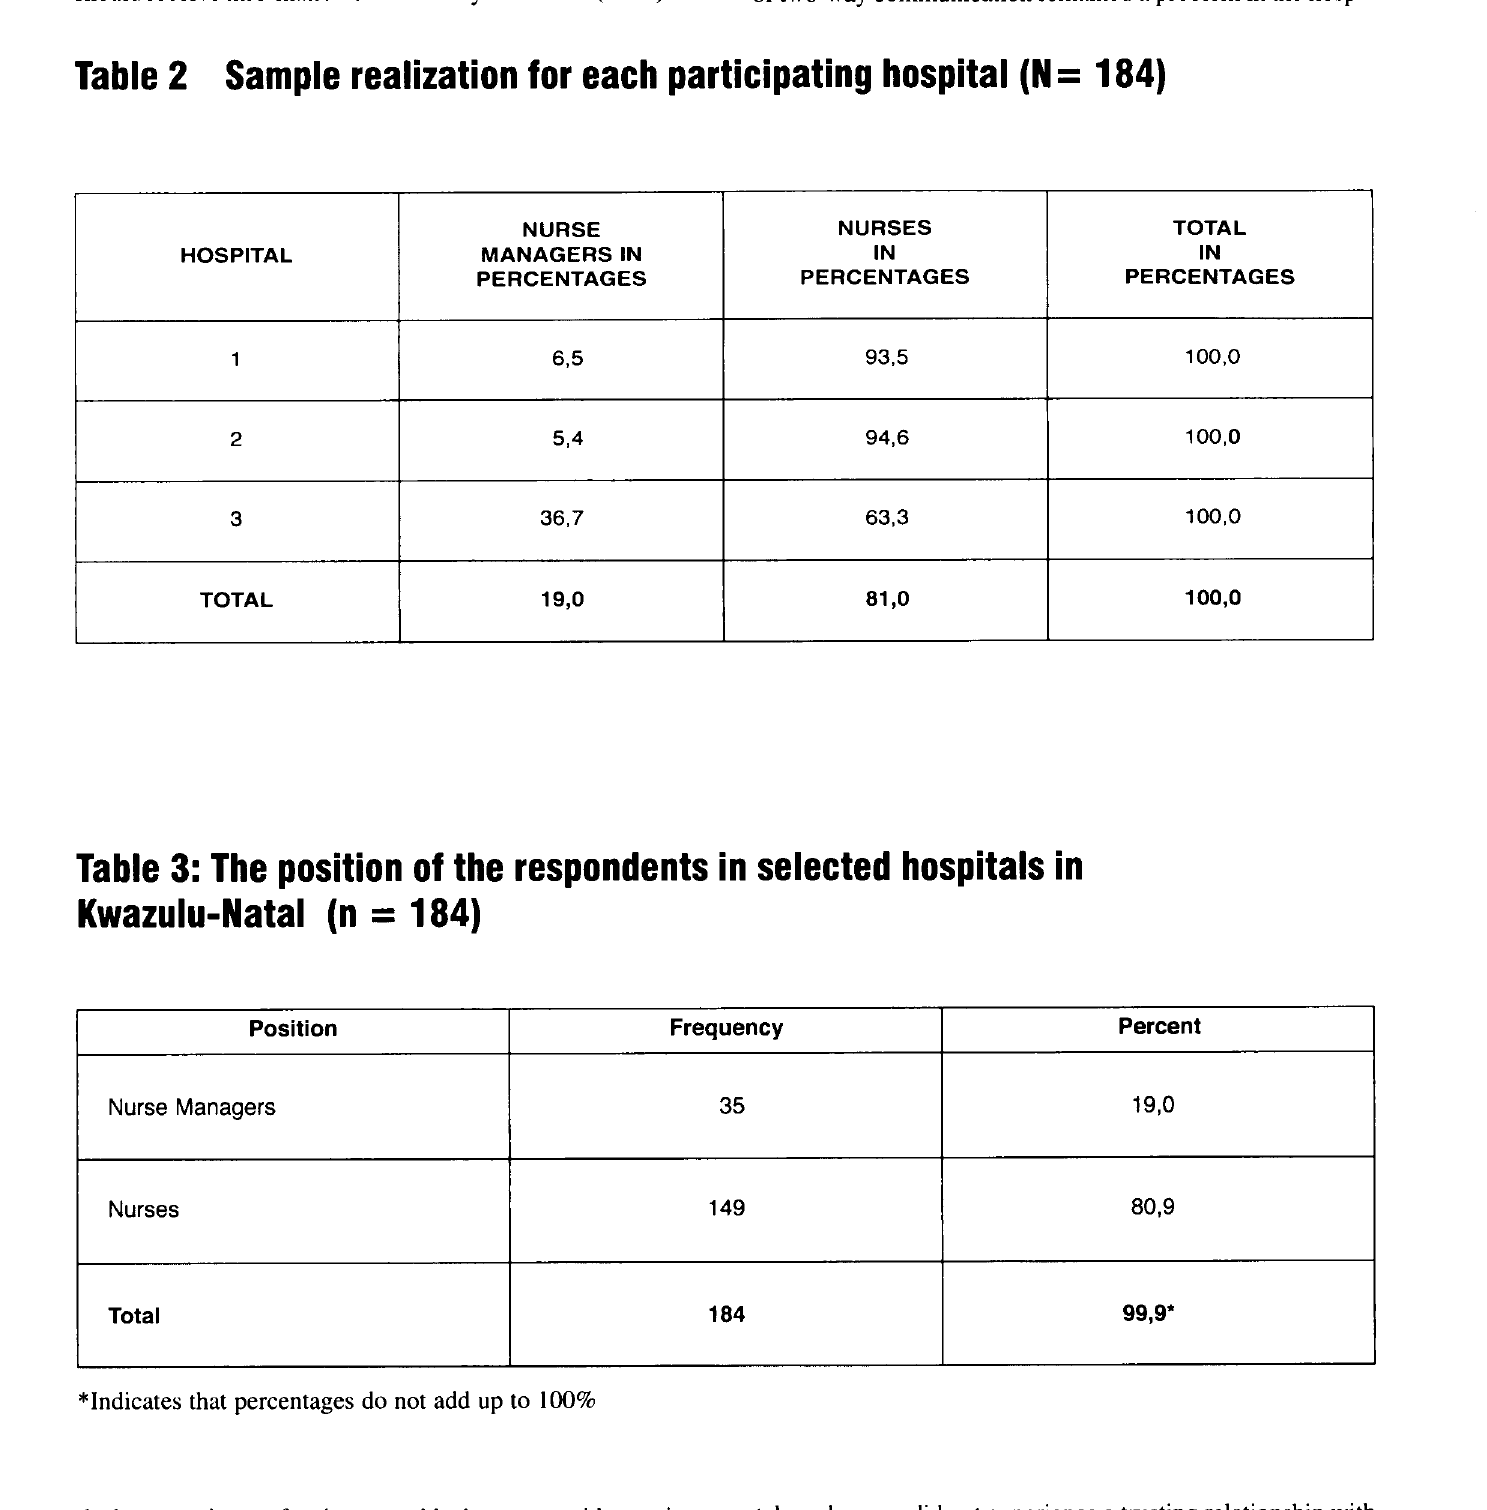
Table 3: The position of the respondents in selected hospitals in Kwazulu-Natal (n =